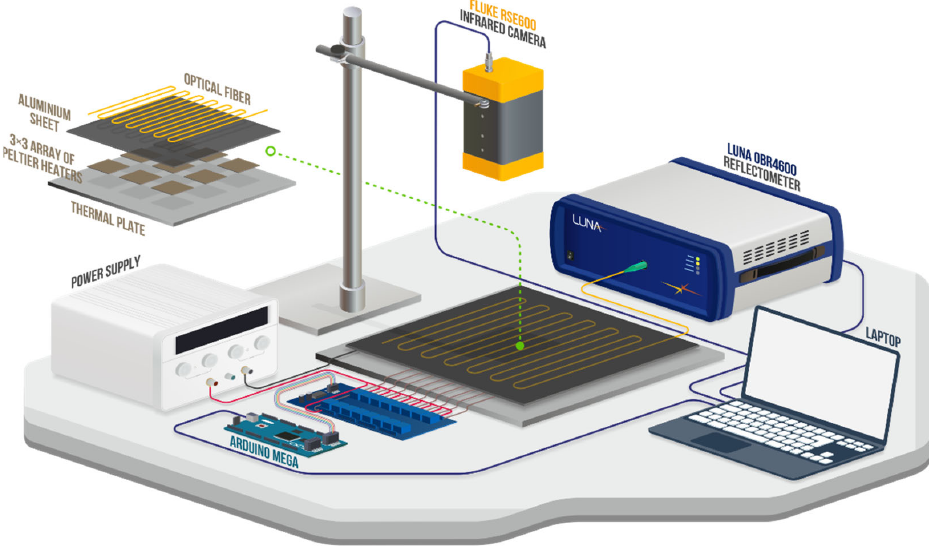
Figure 3. Experimental setup for collecting data from a sensor panel with integrated fiber.